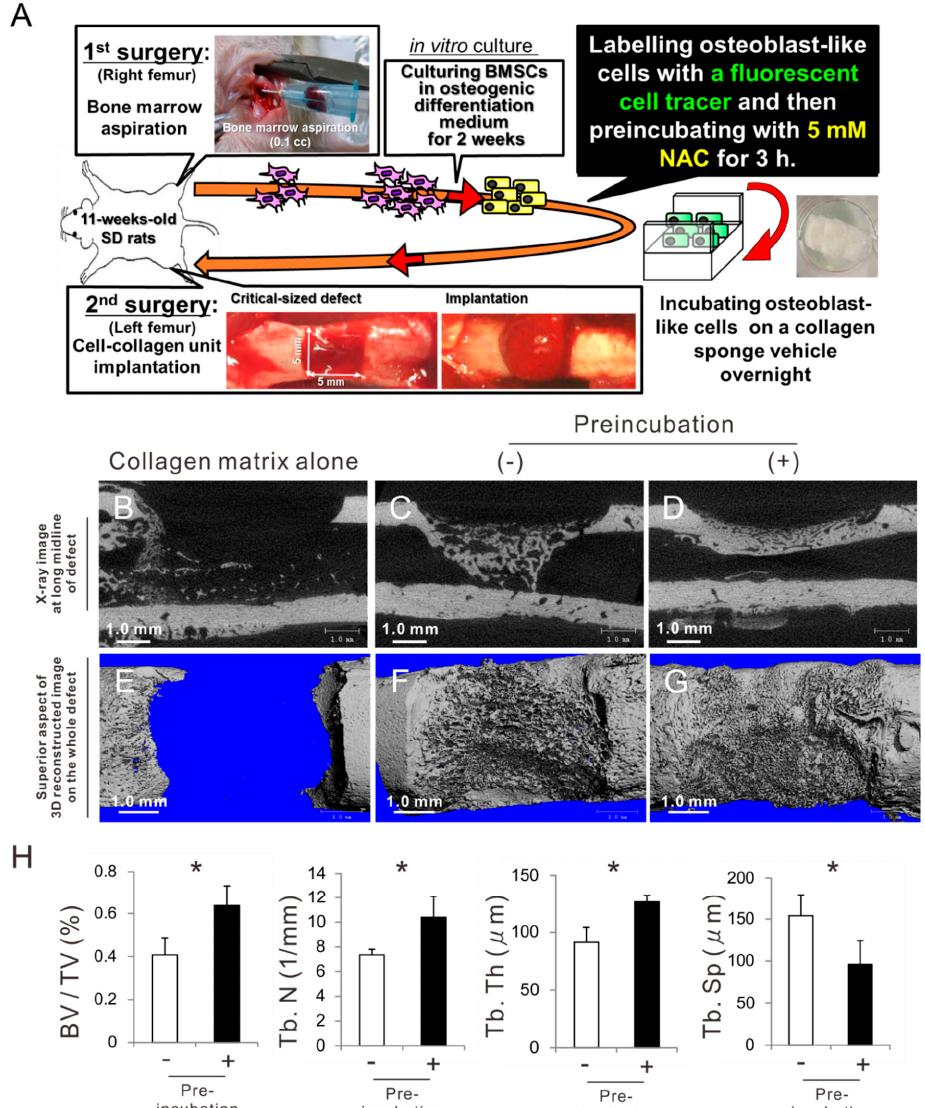
Figure 7. E ff ects of preconditioning osteoblast-like cells with N -acetyl- L -cysteine (NAC) on bone regeneration in autologous local cell transplantation. ( A ) Scheme indicating outline of the autologous local cell transplantation model. Bone marrow tissue was aspirated from the right femur bone in the first surgery. Bone marrow stromal cells (BMSCs) were cultured on a 10-cm polystyrene dish in an osteogenic di ff erentiation medium for 2 weeks for the purpose of cell growth and di ff erentiation into osteoblast-like cells. At confluence, the cells were labeled with a quantum-dot fluorescent tracer and then preincubated with 5 mM NAC for 3 h. The cells were seeded on a collagen sponge in a NAC-free growth medium. After overnight incubation, the cell-collagen unit was implanted into a critical-sized defect (5 × 5 mm) created on the opposite left femur bone of the donor rat. Representative micro-computed tomography images of the original grayscale cross-section at the long midline of the defect ( B – D ) and overhead view of constructed three-dimensional bone architecture for the defect ( E – G ) 3 weeks after implantation of a collagen sponge alone ( B , E ) or autologous rat osteoblast-like cells with ( D , G ) and without ( C , F ) preincubation with 5 mM NAC for 3 h. Quantitative assessment of three-dimensional bone morphometrical parameters ( H ), bone volume fraction (BV / TV) and trabecular number (Tb. N), thickness (Tb. Th) and separation (Tb. Sp) was performed in the areas of interest in the cortical and bone marrow space regions. The presented data represent the mean ± standard deviation ( n = 4). Asterisks indicate statistically significant di ff erences ( p < 0.05 , Student’s or Welch’s